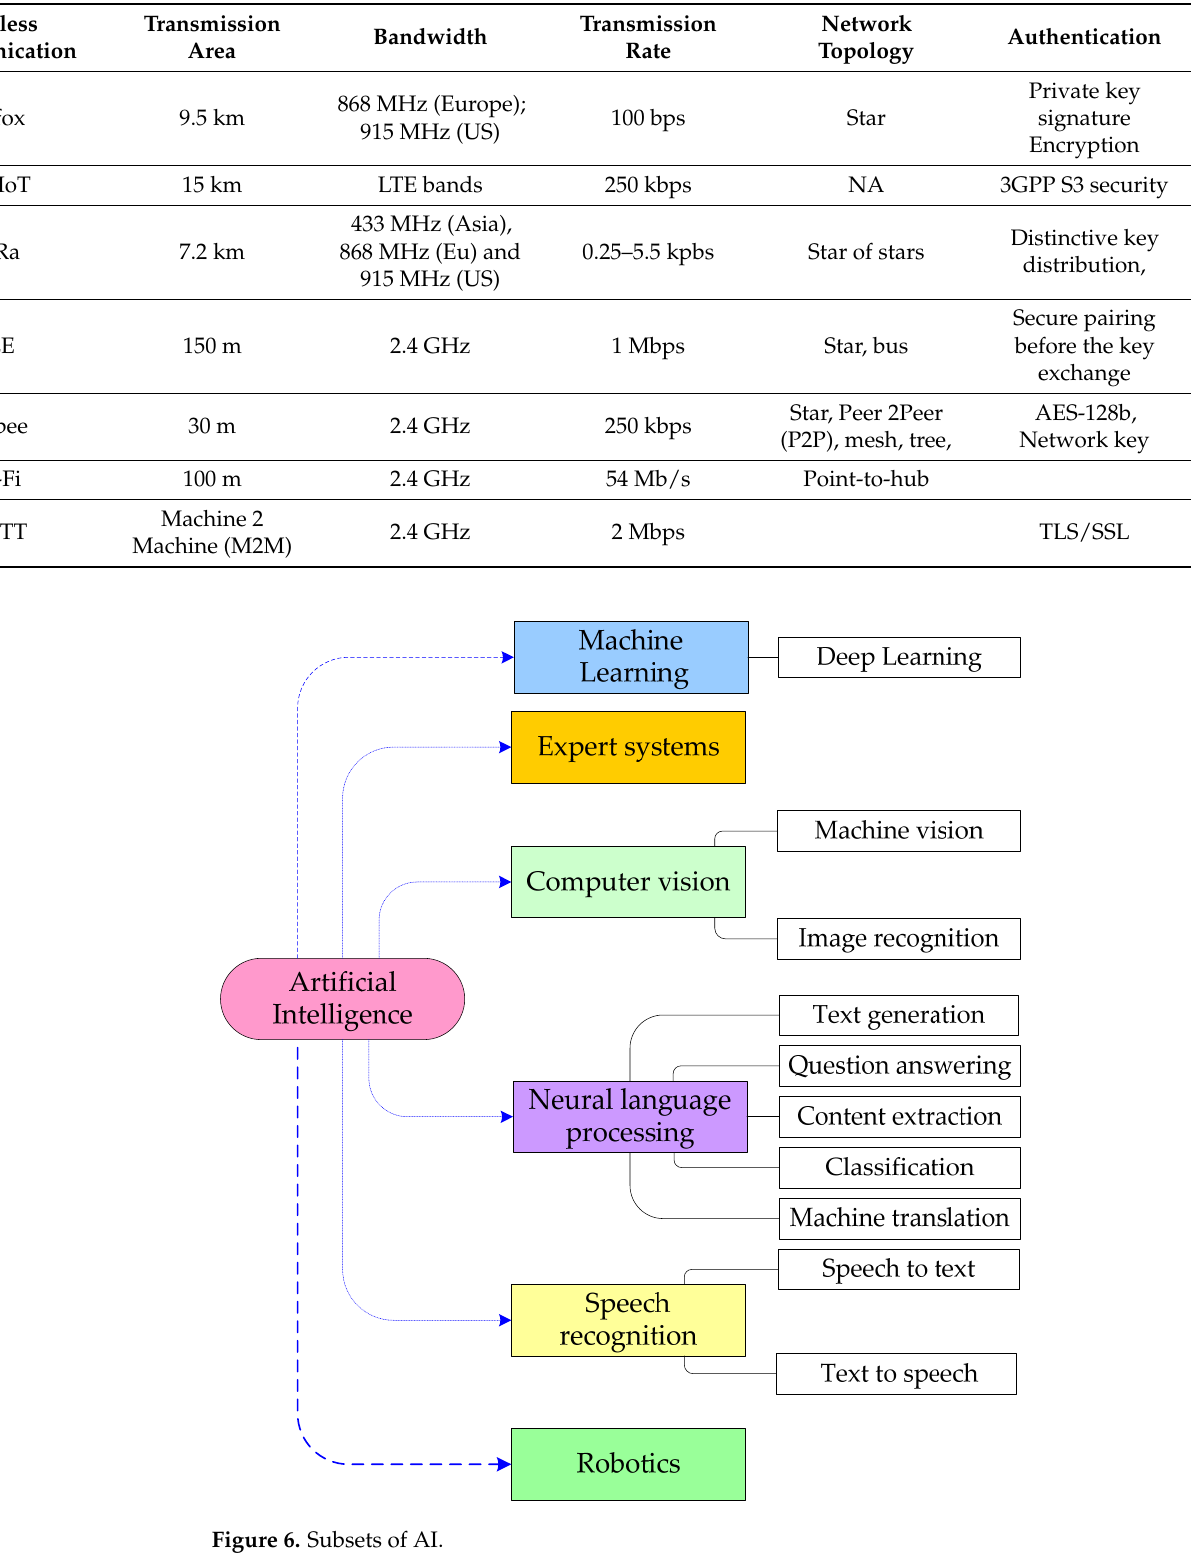
Table 2. Wireless Communication Protocols [30].